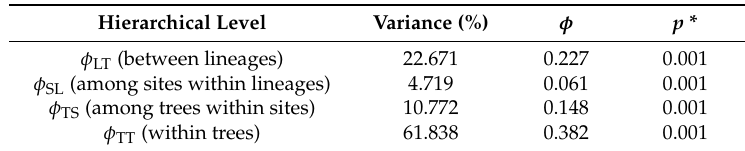
Table 3. Table summarizing the results of the analysis of molecular variance (AMOVA) performed with the 454 P. gaeumannii isolates possessing unique MLGs. The relative genetic variances explained by each of the levels of the population hierarchy are shown, and φ (Phi) statistics are shown as estimates of subpopulation differentiation and gene flow.